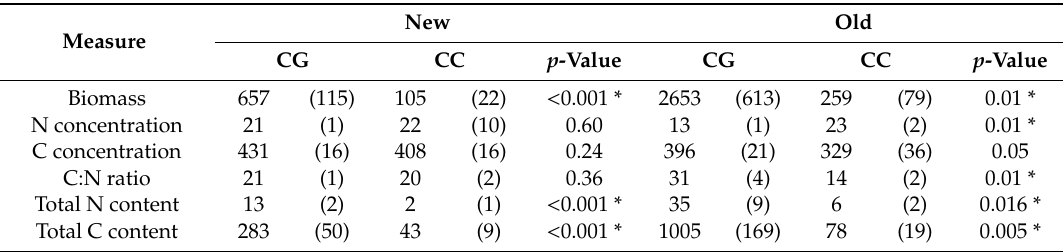
Table 4. Mean ( ± SEM) biomass (kg ha − 1 ), N and C concentrations (g kg − 1 ), C:N ratio, and the N and C nutrient content (kg ha − 1 ) of herbaceous ground vegetation in Canopy Gap (CG) plots and Canopy Closed (CC) plots at the new and old infestation sites.